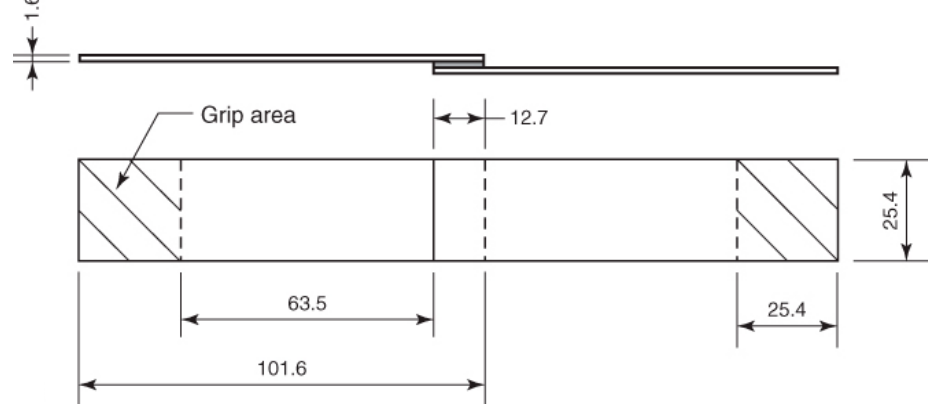
Figure 3. Scheme of test specimen for single lap joints test according to ASTM D 1002-10 standard. All dimensions in mm.